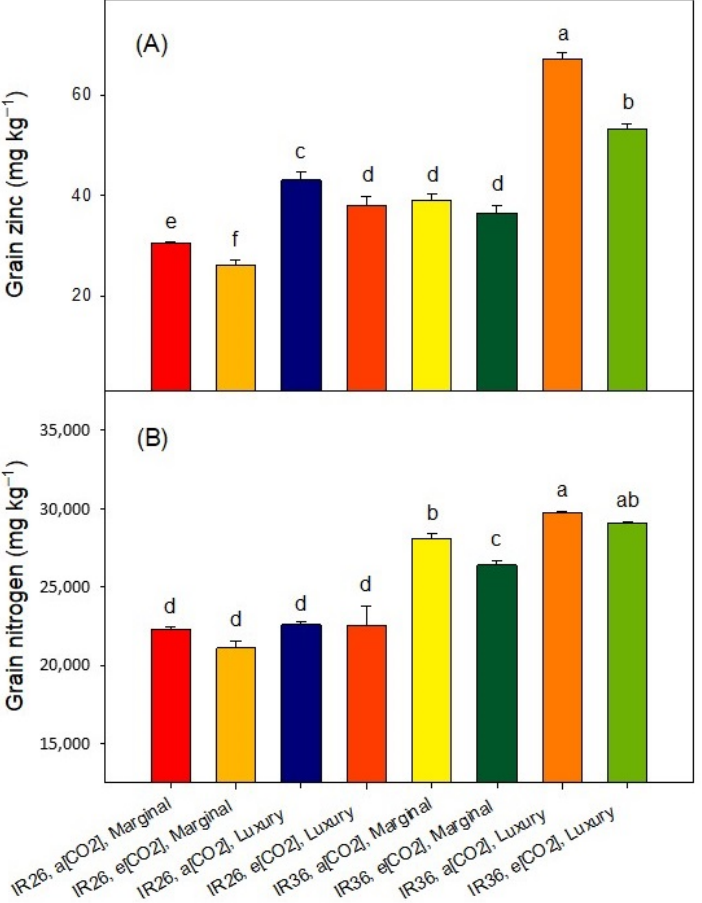
Figure 5. Treatment effects on the ( A ) [Zn] and ( B ) [N] in the grain. The values are means of three replicates, the bars represent standard errors, and columns headed by different letters differ significantly ( p < 0.05). The ANOVA is presented in Tables S2 and S3. For ANOVA see Tables S6 and S7.